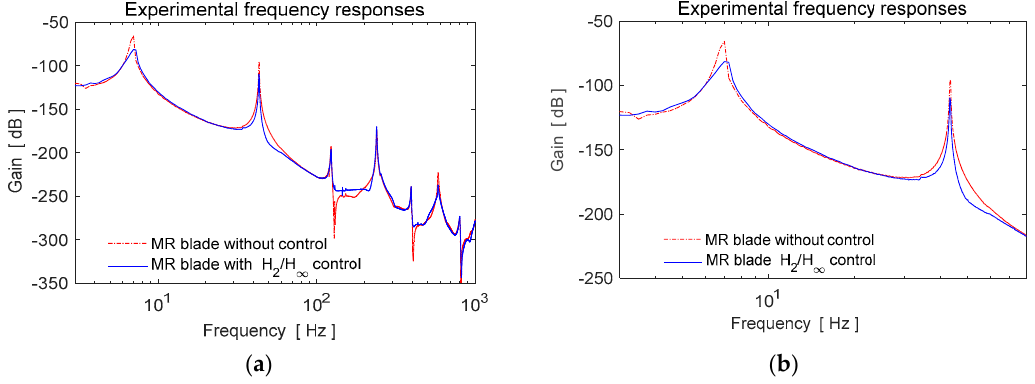
Figure 15. Experimental frequency responses of the closed loop ( a ) all modes, ( b ) first two modes. Table 2. Amount of reduction in gains with H 2 / H ∞ controller.